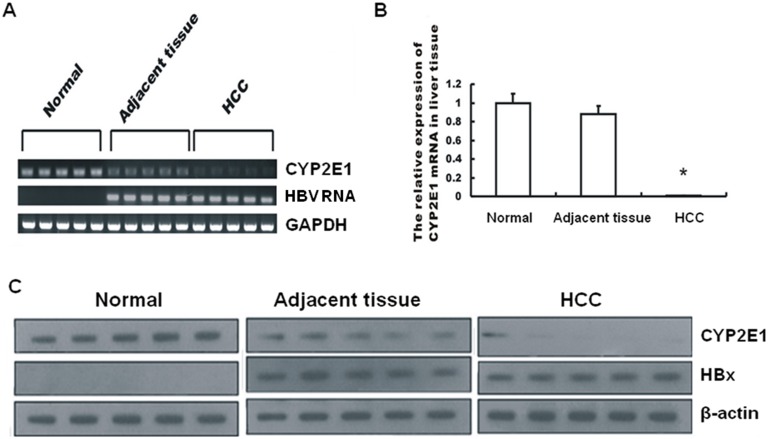
Enhanced HBx expression correlates with lowered CYP2E1 level in livers of HCC patients.(A) CYP2E1 and HBV RNA were determined by RT-PCR using GAPDH as an internal control in surgically resected human normal hepatic tissue, HCC tissue and its adjacent tissues. (B) CYP2E1 mRNA level was detected by real time quantitative PCR. (C) CYP2E1 and HBx protein were measured by Western blotting using β-actin as an internal control. The values were represented as the mean±standard deviation; *, P<0.001 vs. normal tissue or the adjacent tissue.